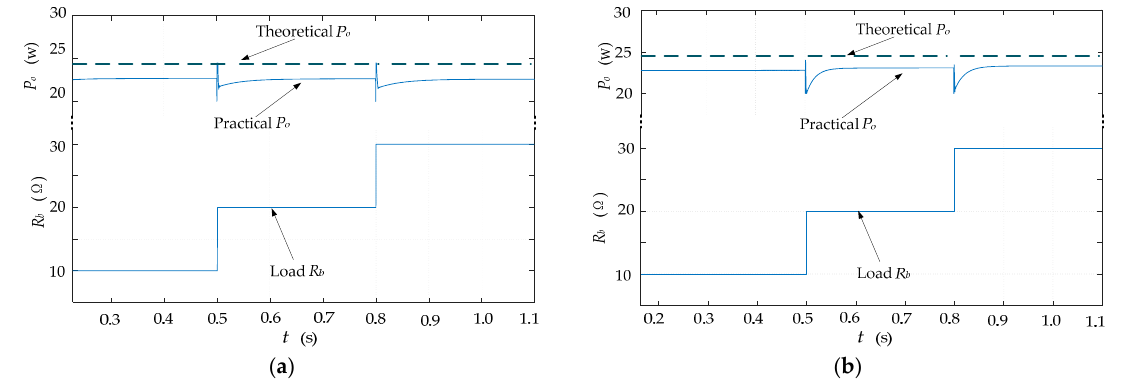
Figure 8. Maximum power tracking when load R b changes with different k : ( a ) k = 0.0811; ( b ) k = 0.0448.